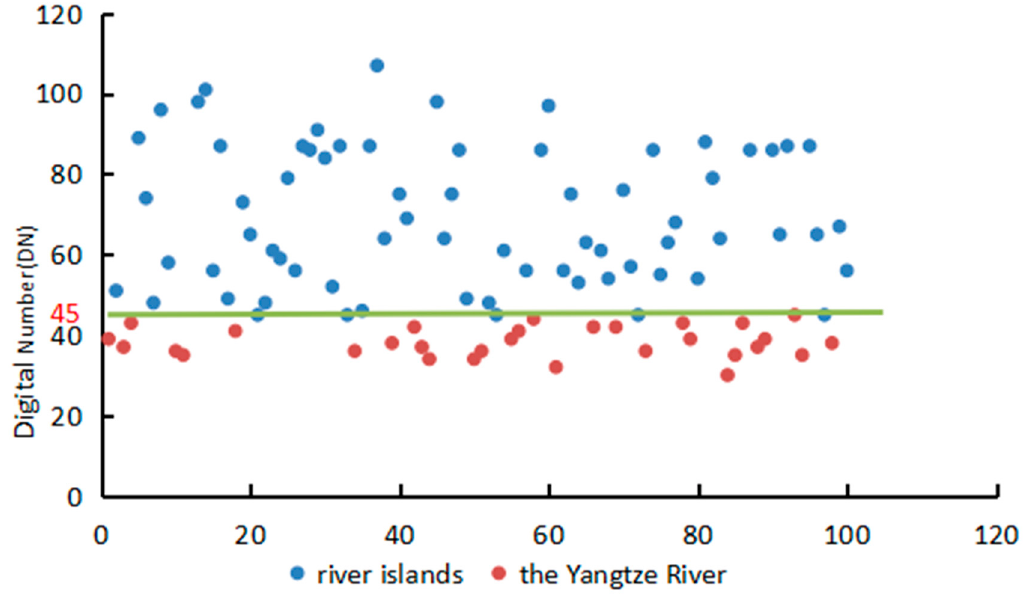
Figure 3. The value of the demarcation between river islands and the Yangtze River. X-axis represents point numbers and y-axis represents digital number (DN) value at this point in the image.